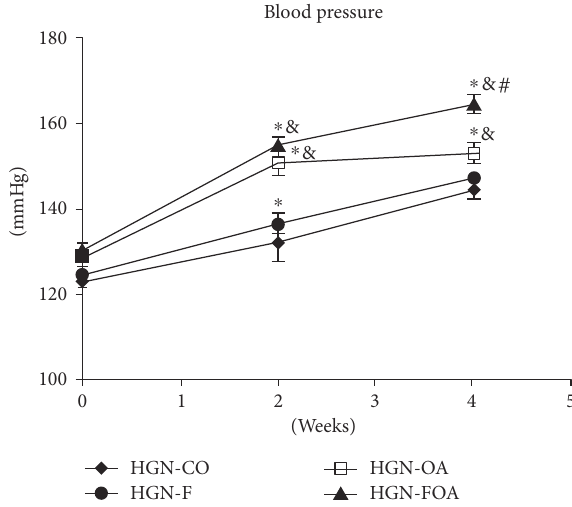
Figure 2: Blood pressure in HGN groups, basally and on the 2nd and 4th weeks after beginning the treatment. NGN (normogonadic); CO (control); F (fructose); OA (oxonic acid); FOA (fructose and oxonic acid). ∗ p < 0 001 control group versus F, OA, and FOA groups on the 2nd week; control group versus OA and FOA groups on the 4th week. & p < 0 01 F group versus OA and FOA groups on the 2nd and 4th weeks. # p < 0 01 OA group versus FOA groups on the 4th week.